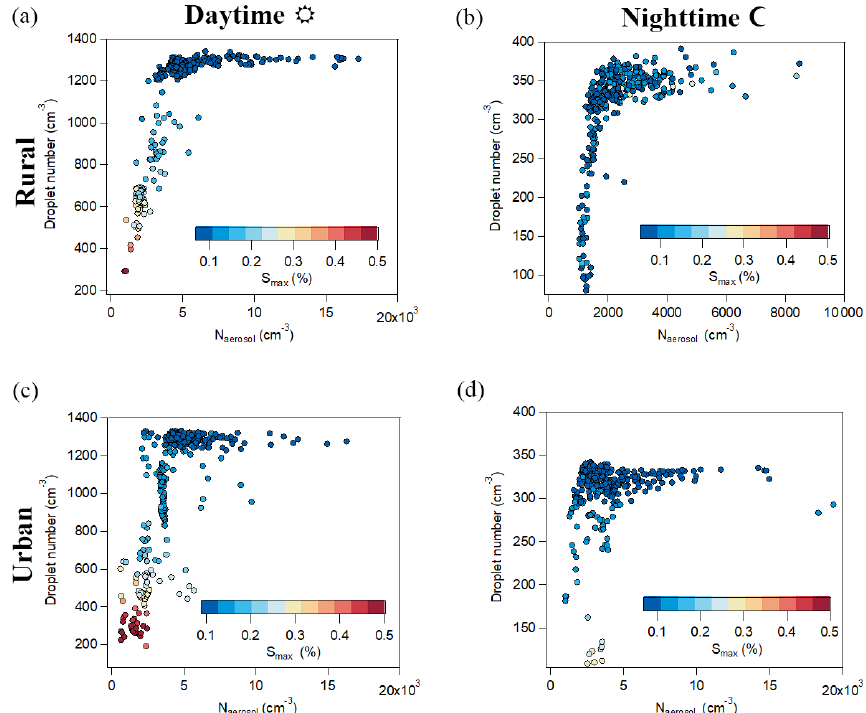
Figure 4. Cloud droplet number vs. total aerosol number for the derived characteristic vertical velocity ( w ∗ ) of each flight (Table 4). (a) For the rural sector during daytime (Flight 5) and (b) nighttime (Flight 15). (c) For urban Atlanta during daytime (Flight 6) and (d) nighttime (Flight 9). Data are colored by maximum